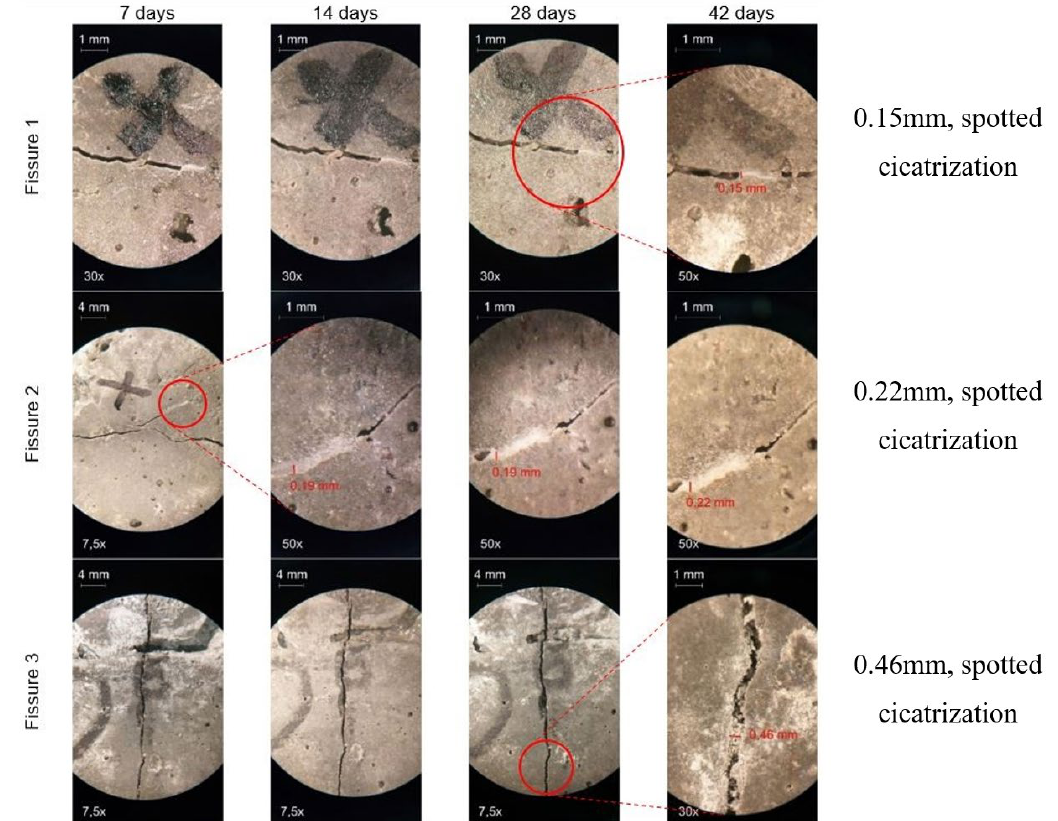
Figure 8 – Self-healing activity of sample BAC.6 at several